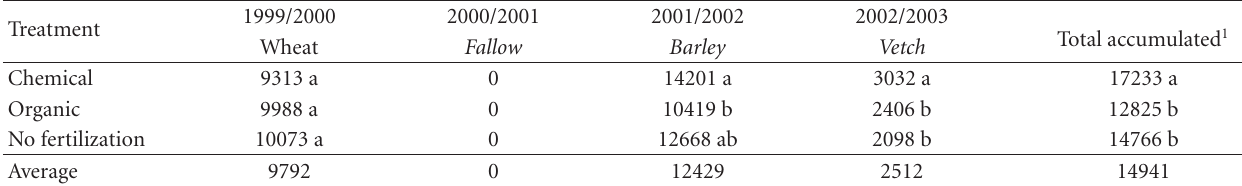
Table 2: Aboveground vegetal biomass (kgha − 1 ) in the di ff erent crops over the period 1999–2003.